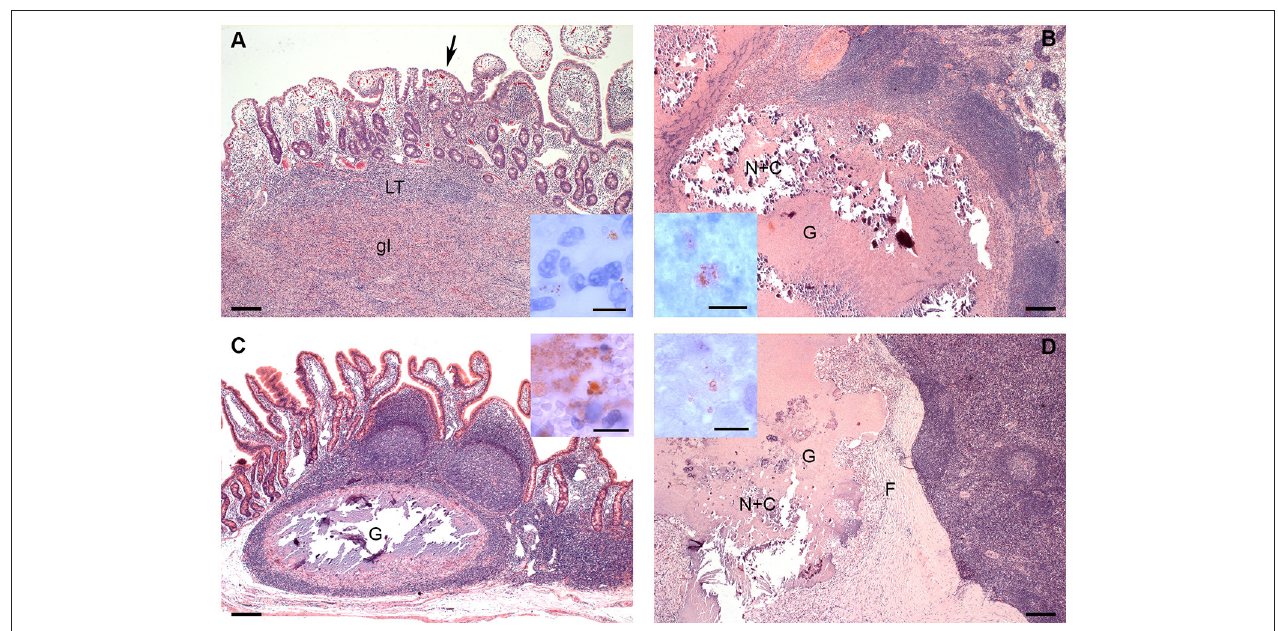
FIGURE 2 | (A–D) . Histologic Lesions in goats inoculated with MAP (A,B) and MAH (C,D) . (A) The granulomatous infiltrate (gI) replaces most of the lymphoid tissue (LT) of a JPP. There are multifocal granulomatous infiltrates (arrow) in the overlying lamina propria. HE-stain; Inset : A few mycobacteria are present in the granulomatous infiltrate in the lamina propria. IHC anti-MAP; (B) Part of a large multicentric granuloma (G) with extensive central necrosis and calcification (N + C) in an ileocolic lymph node. HE-stain; Inset : A few mycobacteria are present within the necrosis. IHC anti-MAP; (C) Well demarcated granuloma with central necrosis and calcification in a JPP. There are no lesions in the adjacent lymphoid tissue or mucosa. HE-stain; Inset : There is a focal area with many mycobacteria at the edge of the necrosis. IHC anti-MAP; (D) Part of a large multicentric granuloma (G) with extensive central necrosis and calcification (N + C) demarcated by a thick fibrous capsule (F) in an ileocolic lymph node. HE-stain; Inset : A few mycobacteria are present within the necrosis. IHC anti-MAP. Bars = 200 µ m, inset bars = 10 µ m.